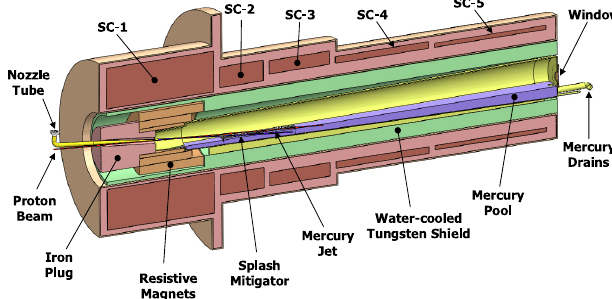
FIG. 2. Concept of a 4-MW target station with a continuous mercury jet target for an intense proton beam. The mercury jet is tilted by 100 mrad with respect to a 20-T solenoid magnet that captures and conducts low-momentum pions into a decay chan- nel. The mercury is collected in a pool that also serves as the proton beam dump.